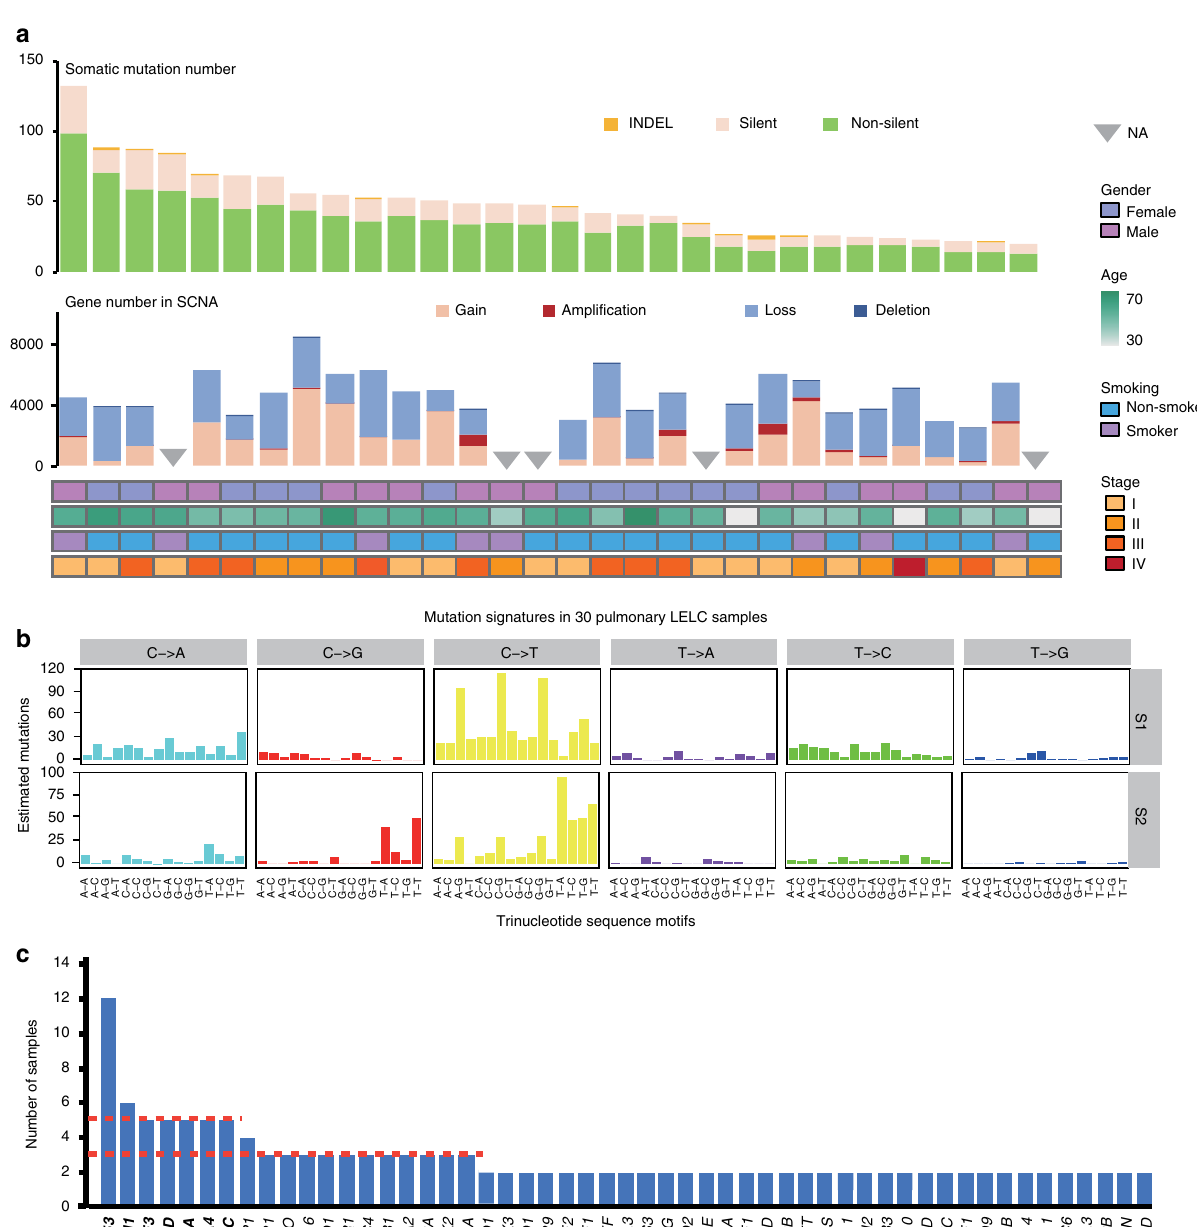
Fig. 1 Somatic mutations and copy number alterations in pulmonary LELC. a The number of somatic mutations and copy number altered genes for each pulmonary LELC samples in the discovery cohort. Gender, age, smoking status, and tumor stages are listed at the bottom according to the samples. b Signatures are displayed according to the 96-substitution classi fi cation, with x -axis showed mutation types and y -axis showed the estimated mutations of each mutation type, which are identi fi ed by a Bayesian NMF algorithm. c Frequently mutated genes in the discovery cohort and validation cohort. The two red dashed line denote three and fi ve mutated patients, respectively. Genes mutated in more than fi ve patients are labeled with bold font.